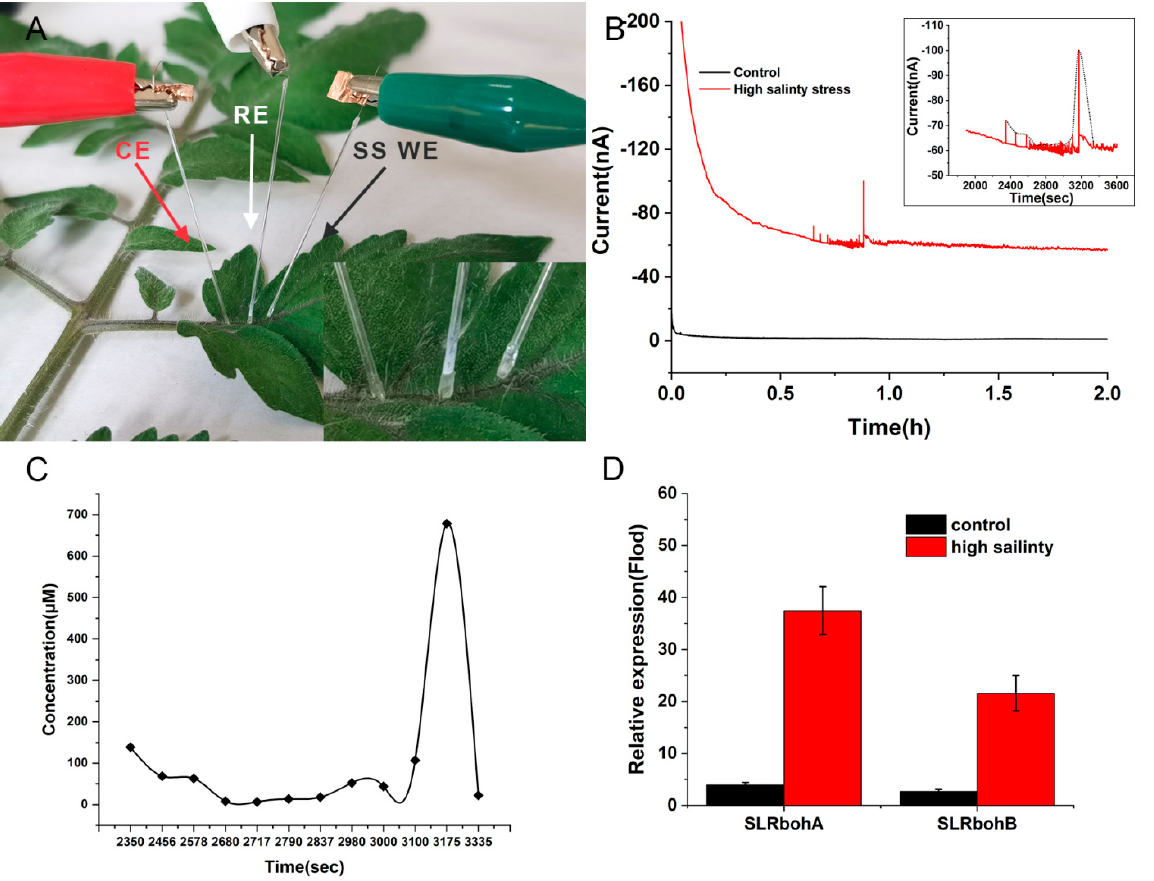
Figure 6. ( A ) In vivo and continuous electrochemical monitoring of H 2 O 2 in vein of the tomato leave based on the Au/SS wire-based electrochemical microsensor, and the inset showed the enlarged part of the analysis area. ( B ) The typical amperometric i-t detection curve of H 2 O 2 in vein of the tomato leaves under the high salinity stress, and the inset showed the enlarged part of H 2 O 2 from 40 to 60 min. ( C ) illustrated the dynamic change in H 2 O 2 in vein of tomato leaf. ( C ) The dynamic change in H 2 O 2 in vein of tomato leaf under the high salinity stress. ( D )The expression level of SLRbohA and SLRbohB under the high salinity stress.